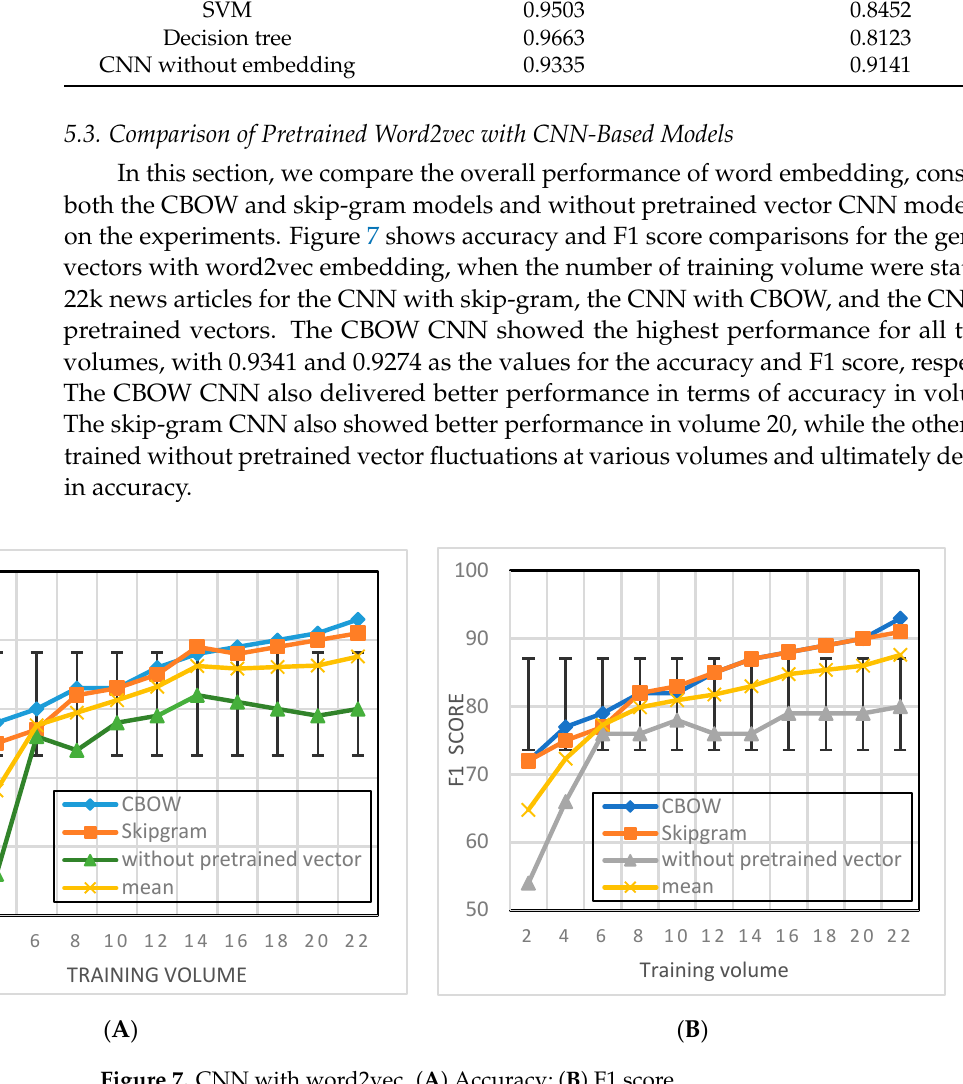
Table 6. Training and validation accuracies between models.